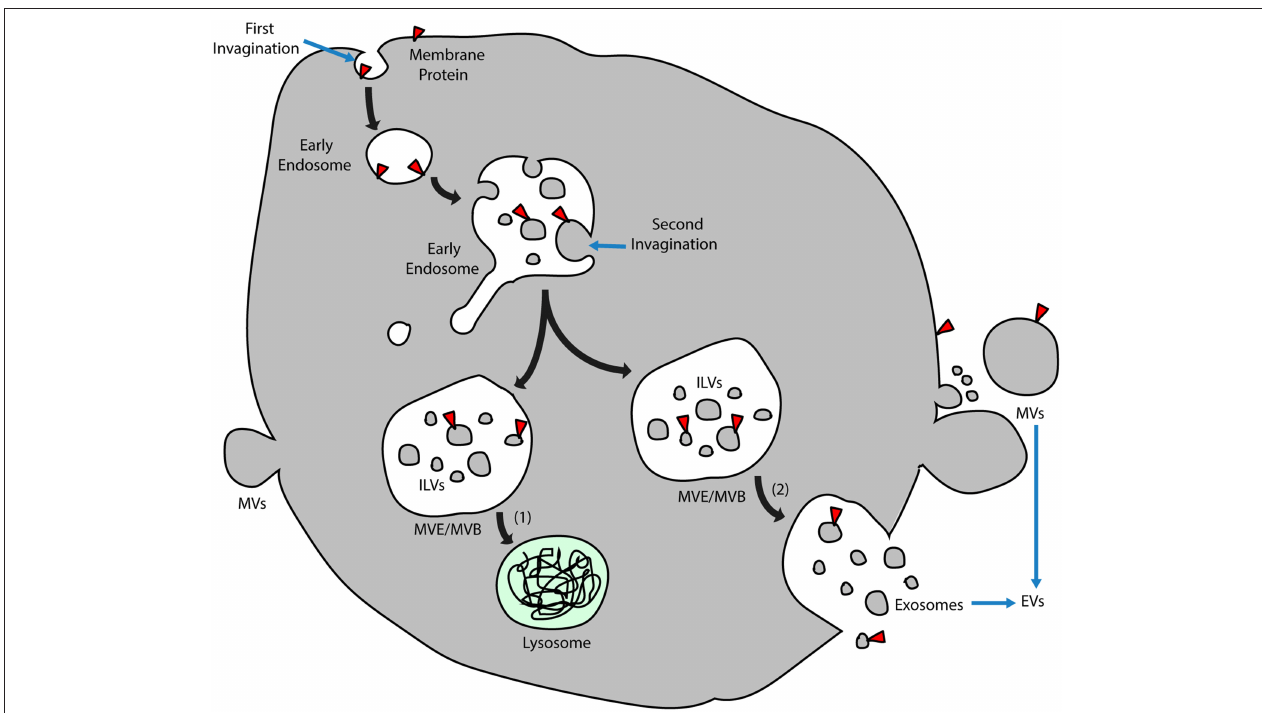
FIGURE 1 | Exosome biogenesis. Early endosomes originate by inward budding of plasma membranes, and the orientation of membrane proteins is turned to the inside of the lumen. After a second invagination, small vesicles form inside the early endosomes during which the direction of membrane proteins turns again and coincides with that of the plasma membrane. These vesicles inside the lumen are known as ILVs, and endosomes that enclose the ILVs are called MVEs/MVBs. Two alternative MVE/MVB pathways include (1) ILVs transported for lysosome degradation and (2) MVE/MVBs coalescing with the plasma membrane and releasing ILVs into the extracellular fluid, which is named exosomes. Another group of EVs directly buds from the plasma membrane, which is called MVs. ILVs, intraluminal vesicles; MVs, microvesicles; MVE/MVB, multivesicular endosome/body; and EVs, extracellular